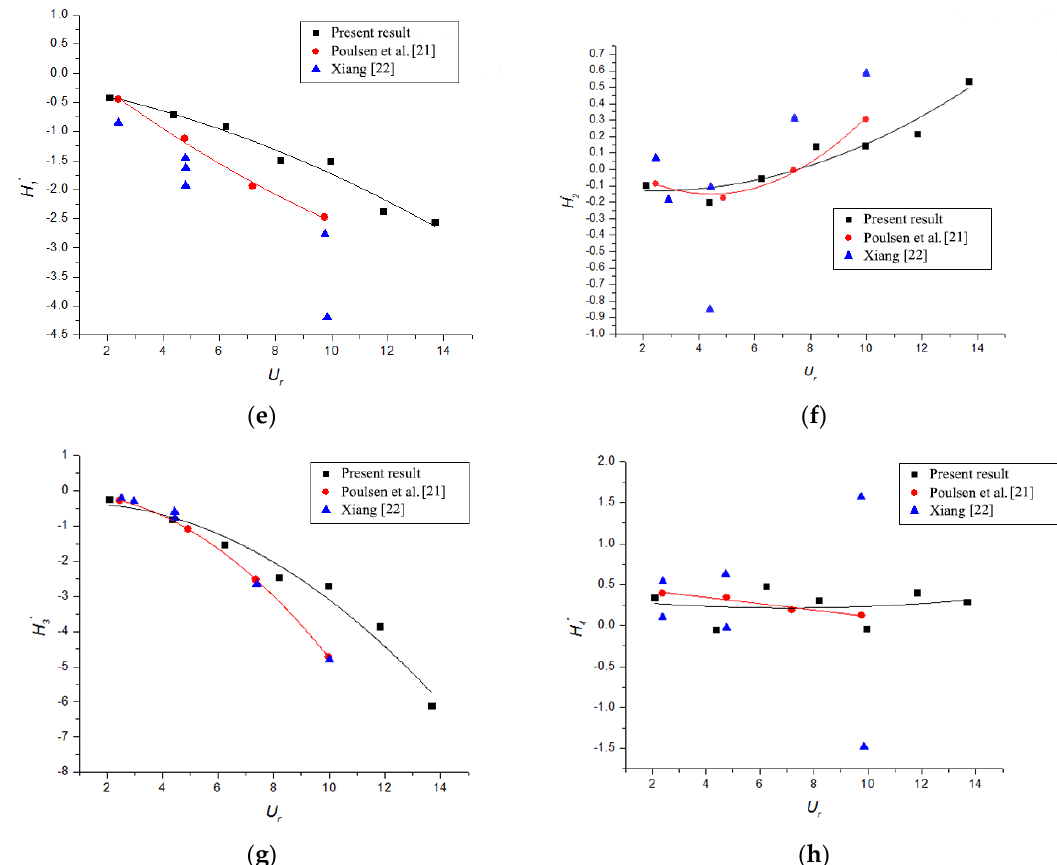
Figure 4. Flutter derivatives (FDs) extracted by the present experiment and comparison with results obtained by Poulsen et al. [21] and Xiang [22]. ( a – d ) A ∗